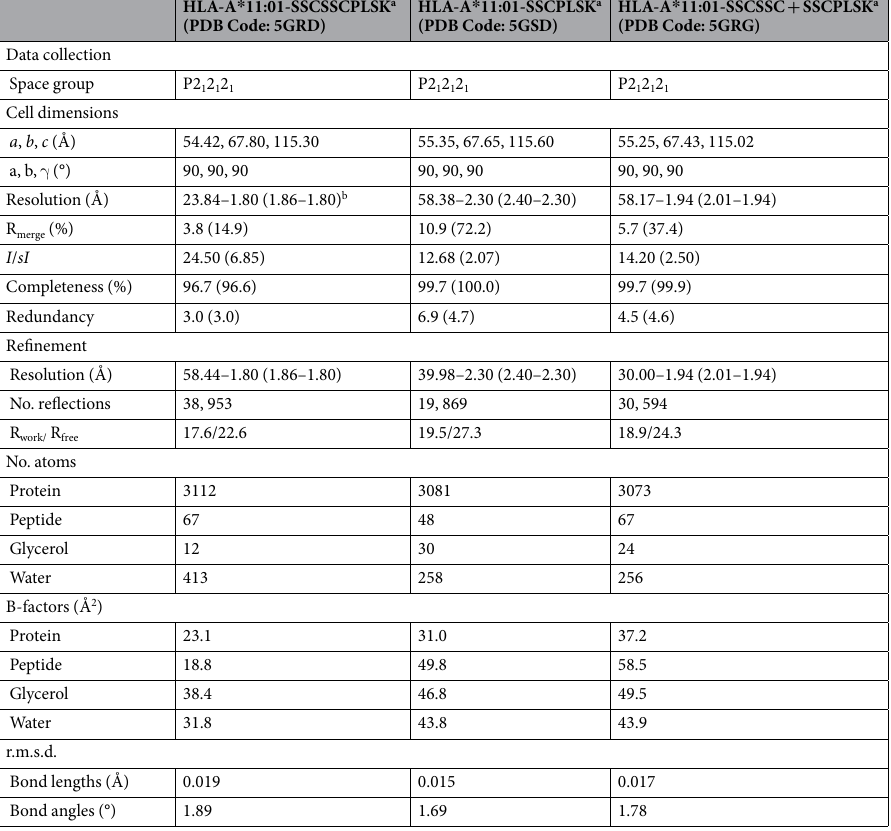
Table 1. Data collection and refinement statistics. a Diffraction data from one crystal was merged into a complete dataset. b Highest resolution shell is shown in parenthesis. r.m.s.d., root-mean-square